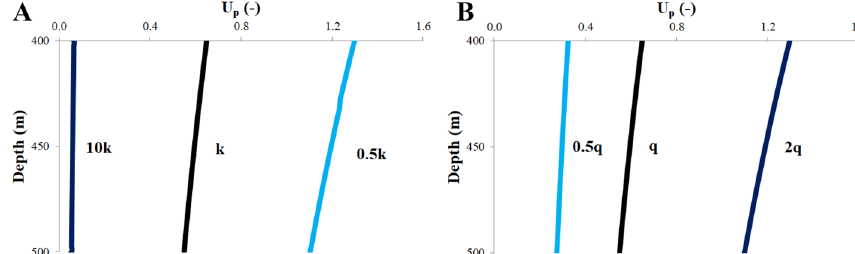
Fig. 21 U p for different intrinsic permeabilities (0.5 k, k and 10 k) of the aquifer ( A ) and for different injection water flow rate (0.5q, q and 2q) ( B )